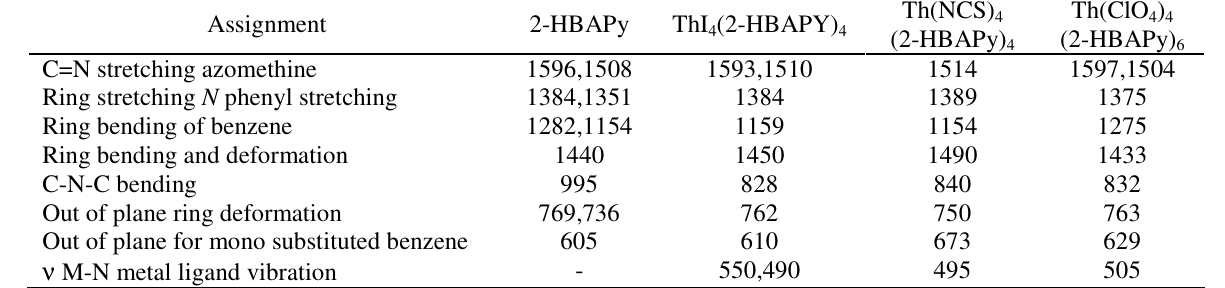
Table 6. Infra red absorpton frequencies (cm -1 ) for dioxouranium(VI) complexes of 2-HBAPy. Assignment